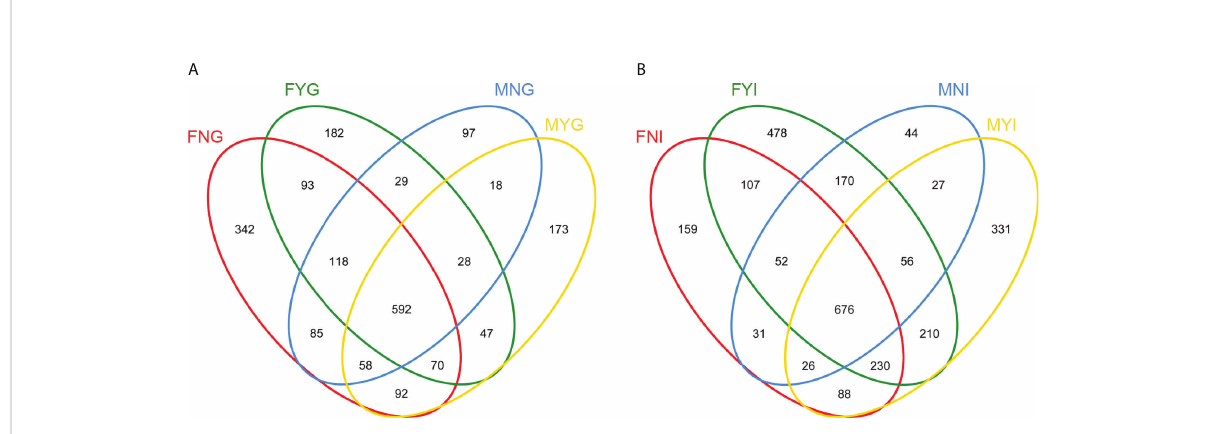
FIGURE 4 Venn diagram of the intestine (A) and gill (B) microbial samples of medium-form populations of Sthenoteuthis oualaniensis. .